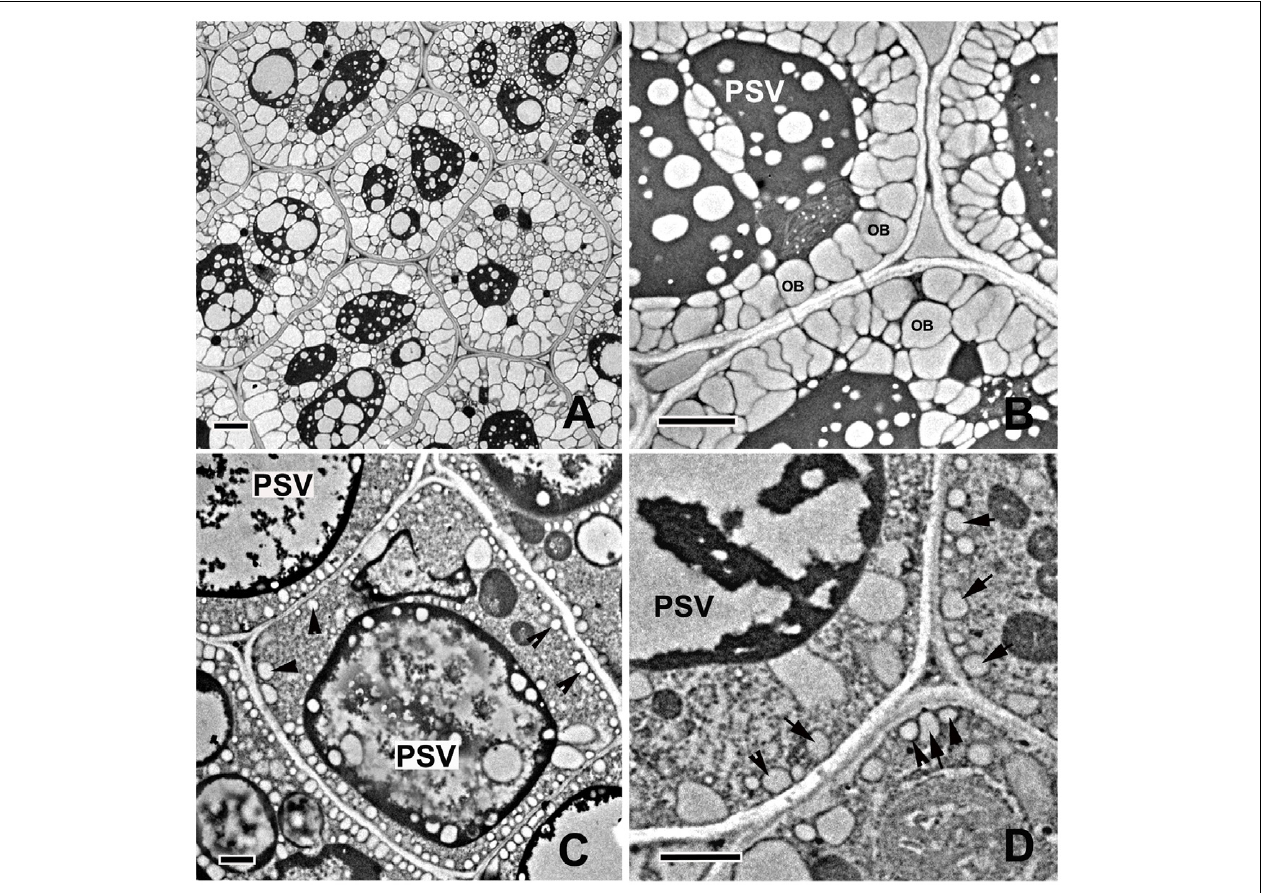
FIGURE 8 | Analysis of the ultrastructure of the storage reserves in mature embryos. Ultrathin sections of both control (A,B) and treated (C,D) embryos growing for 14 DAP were analyzed with a Hitachi-7650 transmission electron microscope. Arrows show the oil bodies in dark-forced embryos. PSVs, protein storage vacuoles; OB, oil bodies. Bar: A,B = 2 µ m; C,D = 1 µ